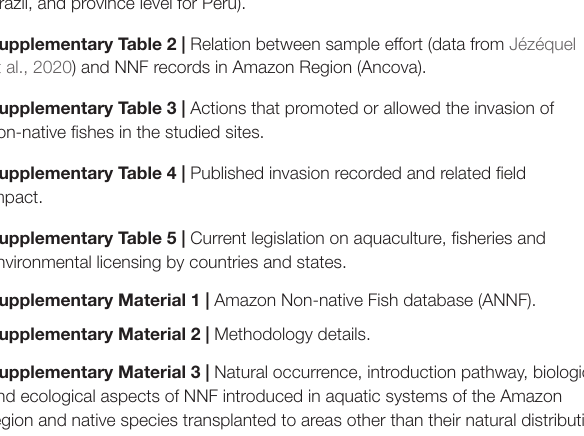
Supplementary Table 1 | Review of regulations for exotic species farming in the Amazon. The regulations were summarized according to geopolitical divisions for